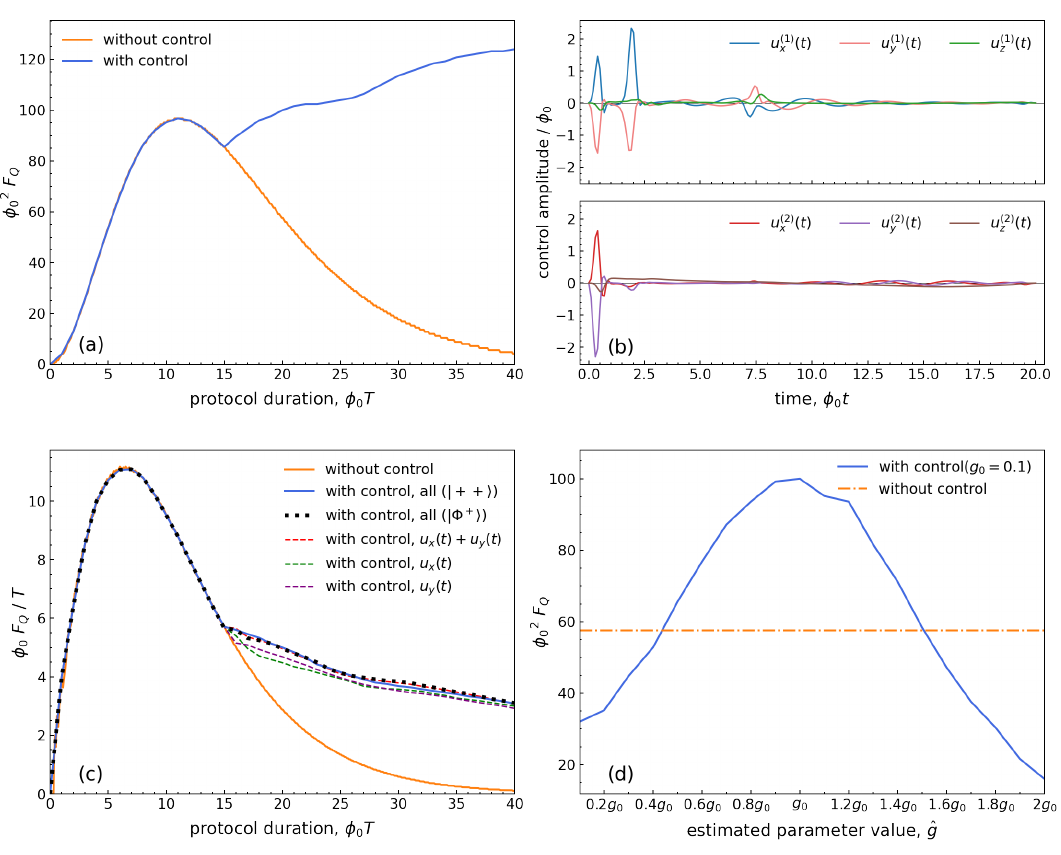
Figure 10: Interaction strength estimation for a two-qubit system with ZZ coupling, − 2 = 0.1, φ = 1.0, dephasing rate γ = 0.1 (a) The QFI (in units of φ g ) achieved 0 0 − 1 without control and with control optimised over a duration T (in units of φ ). 0 (b) Optimal controls obtained using Krotov’s method for the dynamics with T = 20. (c) Normalised QFI (by T ) without control (orange line), with control on both qubits (cid:12) + (cid:11) (black dotted line) as probe, using a product state | ++ 〉 (blue line) or Bell state (cid:12) Φ ( t ) + u ( t ) (red dashed line) on both qubits, restricted with control restricted to u x y ( t ) (green dashed line) or restricted to u ( t ) (purple dashed line). (d) The to u x y QFI achieved at T = 20 by applying controls optimised with different estimated parameter values ˆ g on states evolved under the true parameter value g 0